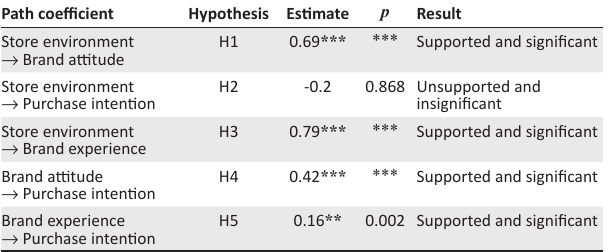
TABLE 5: Hypotheses results and path